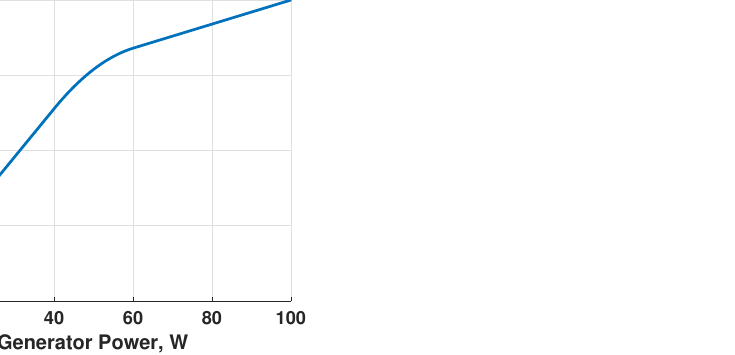
Figure 2. Fuel consumption rate as a function of power output for the 100 W